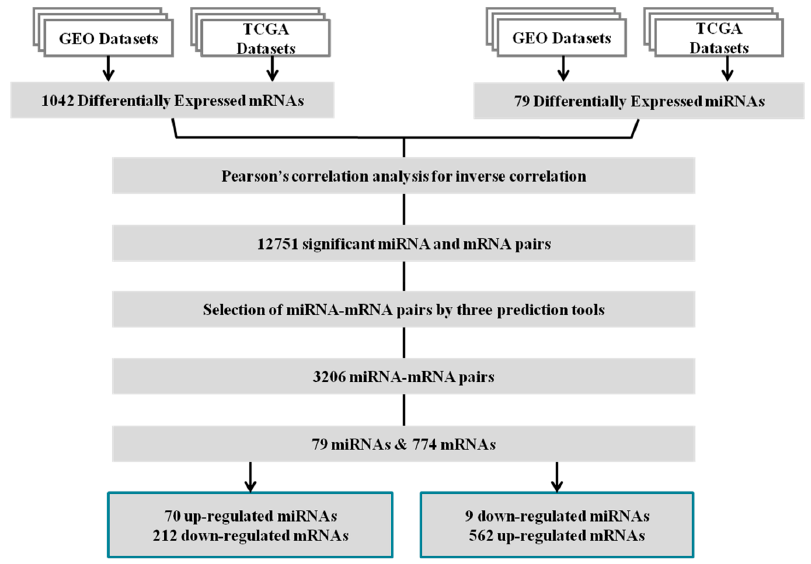
Figure 1. Flow chart for identifying differentially expressed miRNAs and mRNAs.